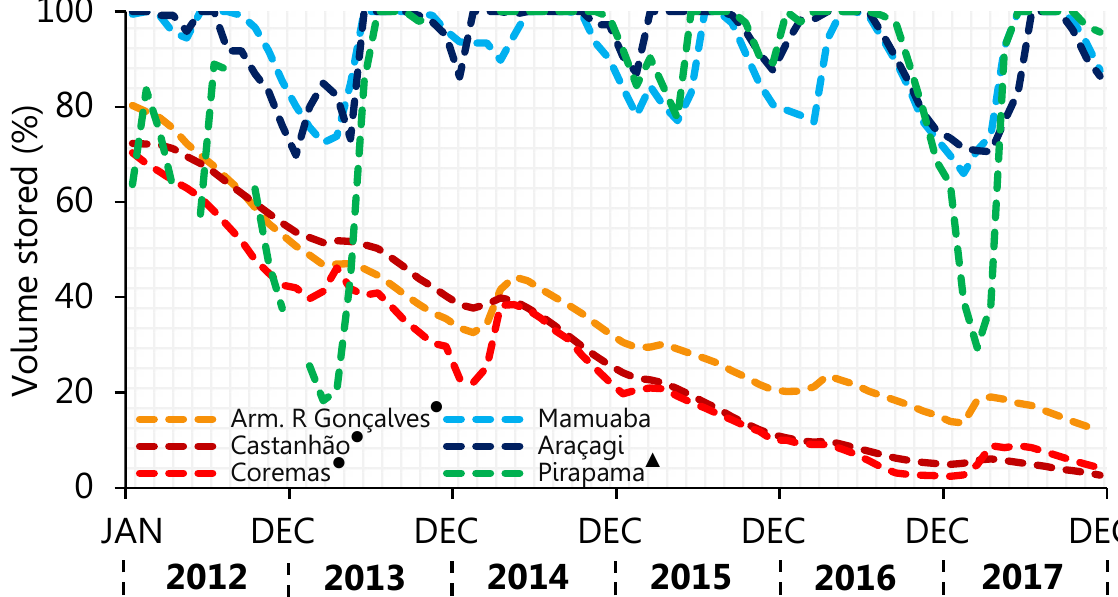
Figure 5. Variation of volume stored of three reservoirs in the semiarid region (Eng. Armando Ribeiro Gonçalves, Castanhão and Coremas) and three in the east coast of Northeast Brazil region (Mamuaba, Araçagi and Pirapama) in the 2012-2017 period. The circles represent negative trend with statistical significance at p=0.01; the triangle represents positive trends with statistical significance at